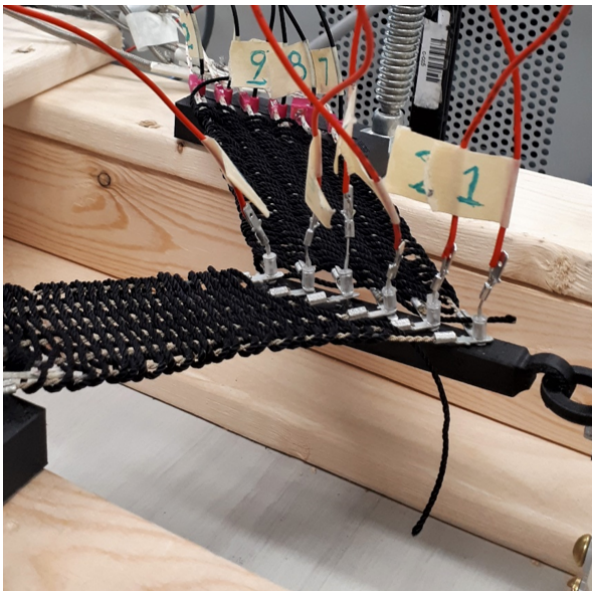
Figure 5. Actuator configuration for the force characterisation